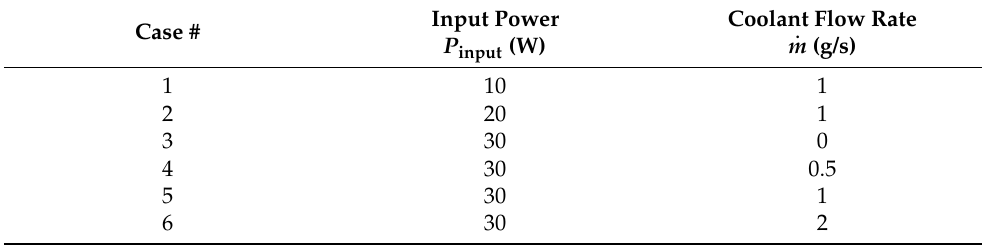
Table 4. Distribution of absorbed thermal energy.